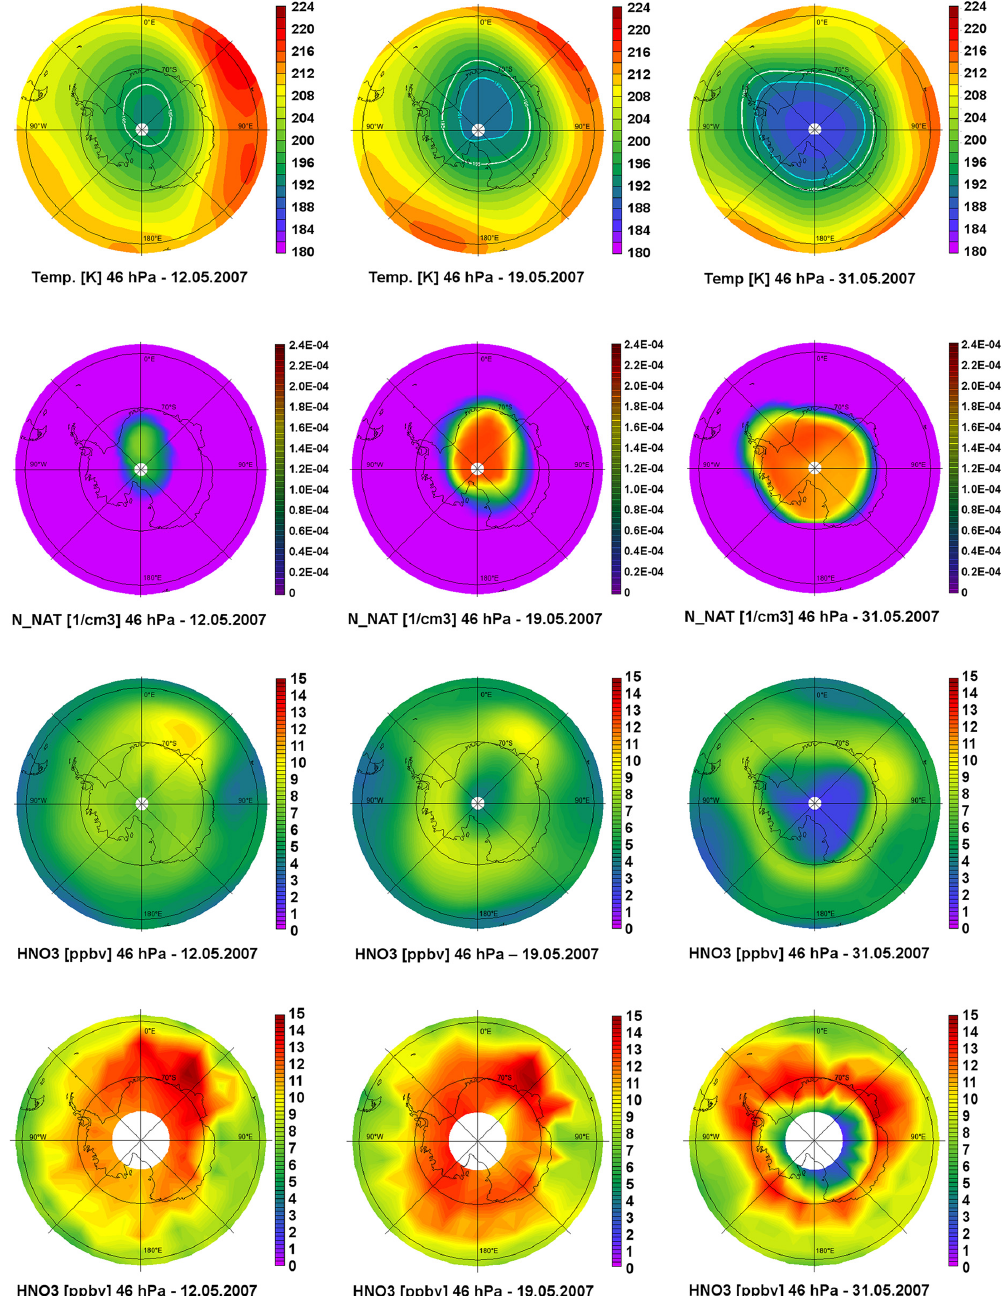
Figure 1. Denitrification in the standard simulation and from MLS – time series of simulated temperature in K (top row) and the simulated distribution of N NAT in cm − 3 (second row) and HNO 3 in ppbv from EMAC (third row) and HNO 3 in ppbv from MLS (bottom row) for southern polar latitudes on 46 hPa approximately 21.6km) for the dates 12 May 2007, 19 May 2007, and 31 May 2007. In the temperature plots the isotherms of 195K (white) and 192K (light blue) are